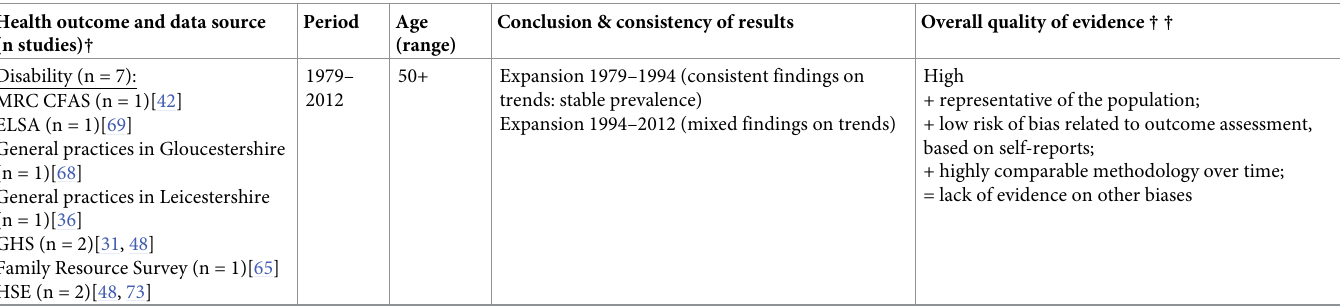
Table 7. The characteristics of evidence on prevalence of each health outcome, with the emphasis on size, consistency and quality